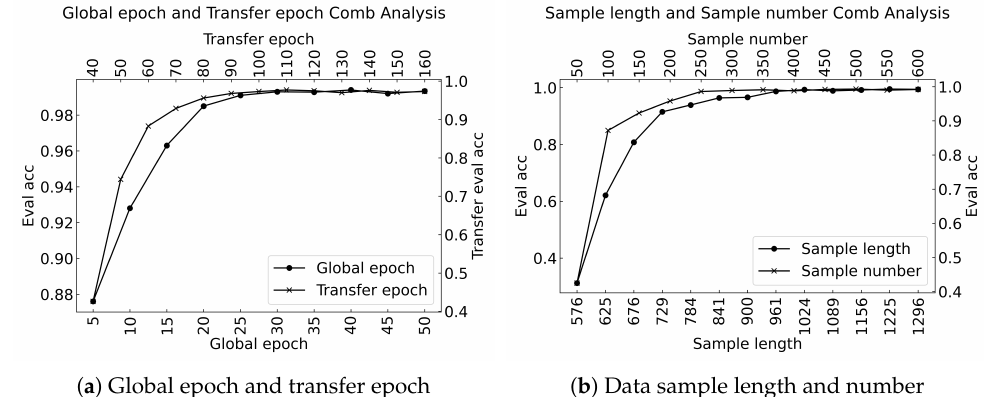
Figure 9. Influence of the hyperparameters on the results. Sub-figure ( a ) indicates the global epoch and transfer epoch, and sub-figure ( b ) corresponds to the data sample length and number.